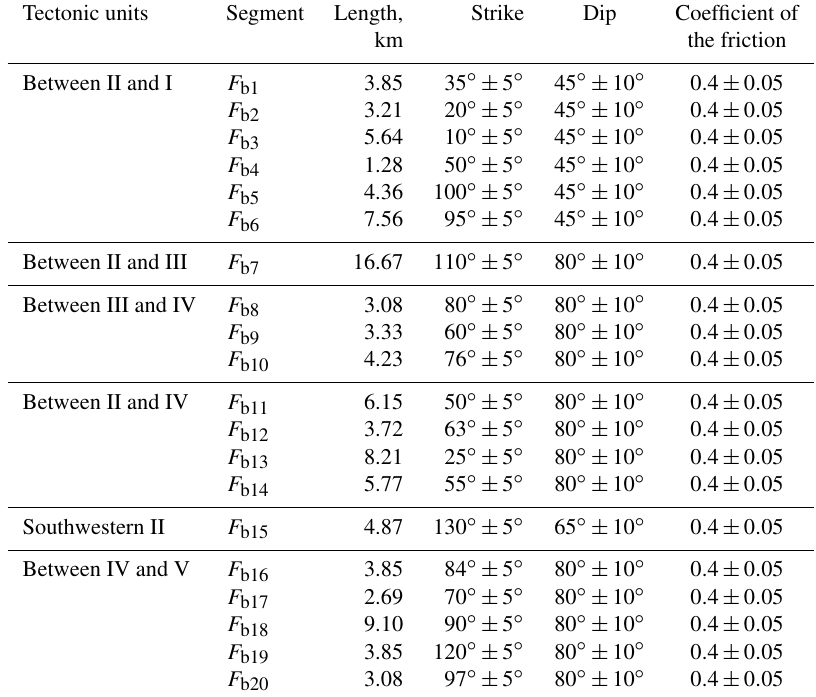
Table 5. The geological information of the main boundary faults used for calculating probabilistic fault slip potential in the MTY EGS field.